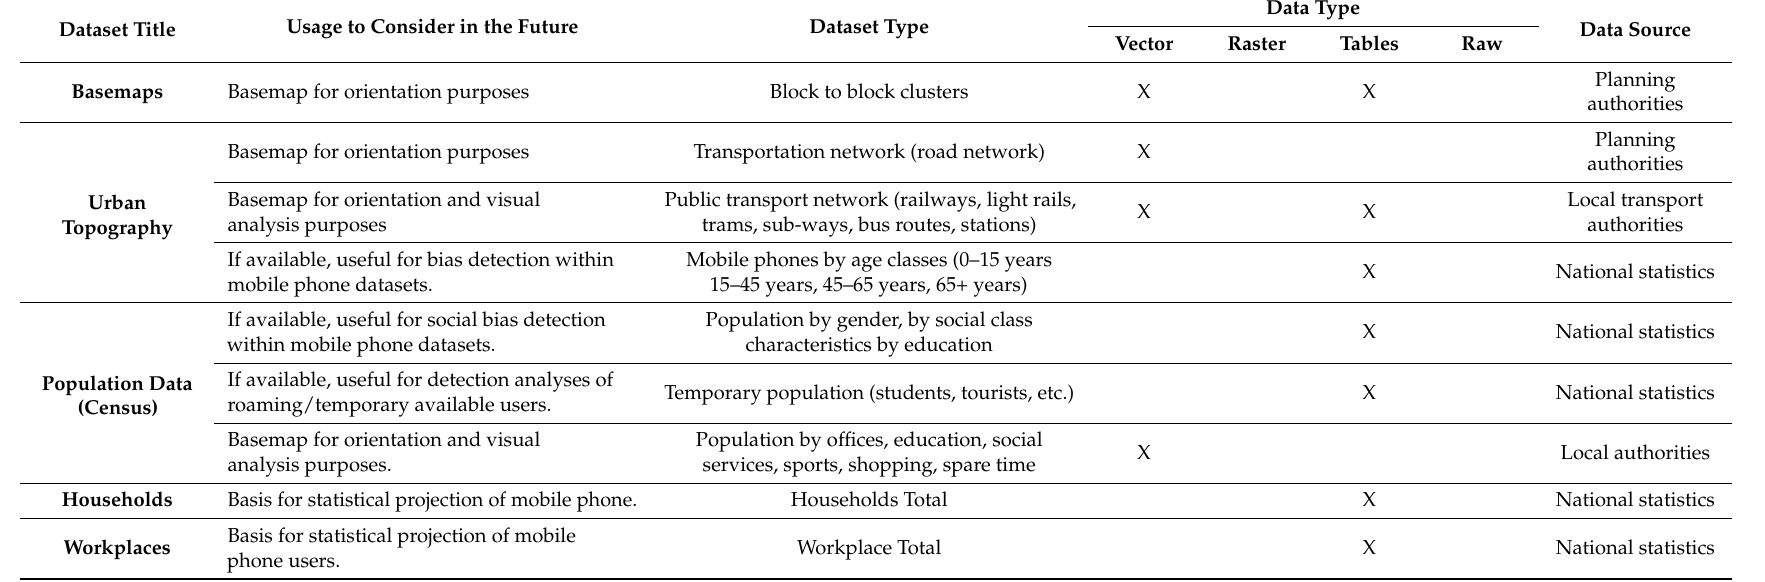
Table 4. Datasets to be considered for future